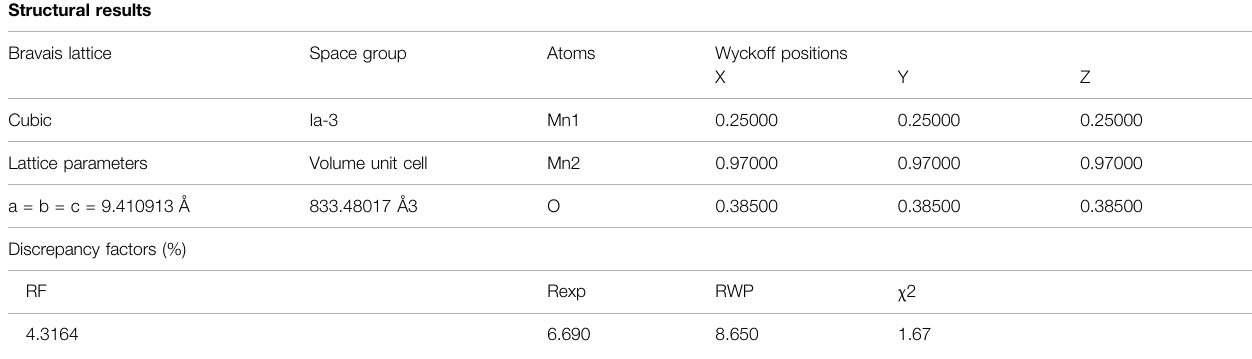
TABLE 1 | Structural parameters extracted from the X-ray diffraction data and Rietveld pro fi le re fi nement of Mn 2 O 3 XRD pro fi le. Structural